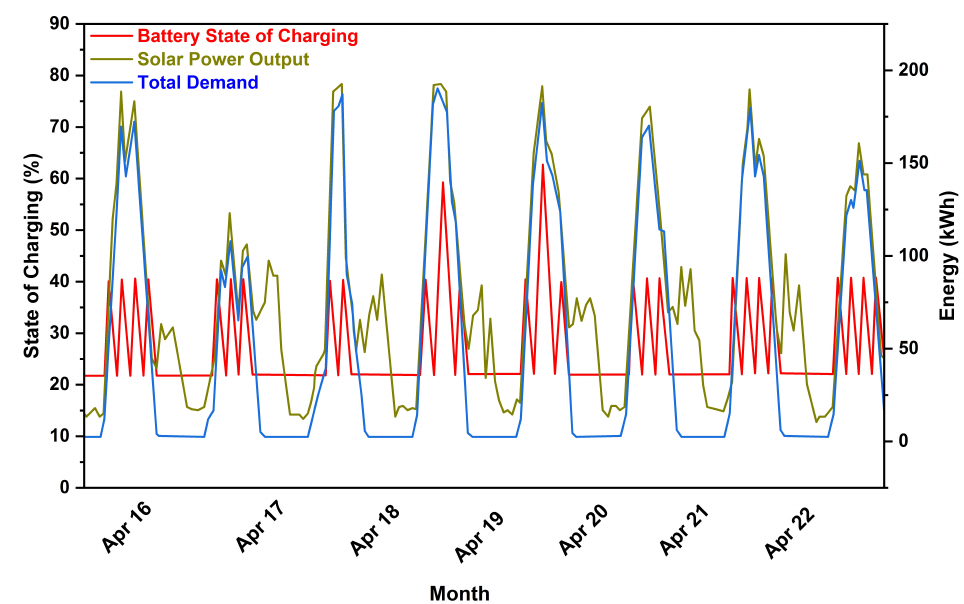
Figure 7. Battery SOC and energy balance of hybrid microgrid system for the third week of April. The SOC of the battery Trojan SAGM 06 315 storage system is delineated in Figure